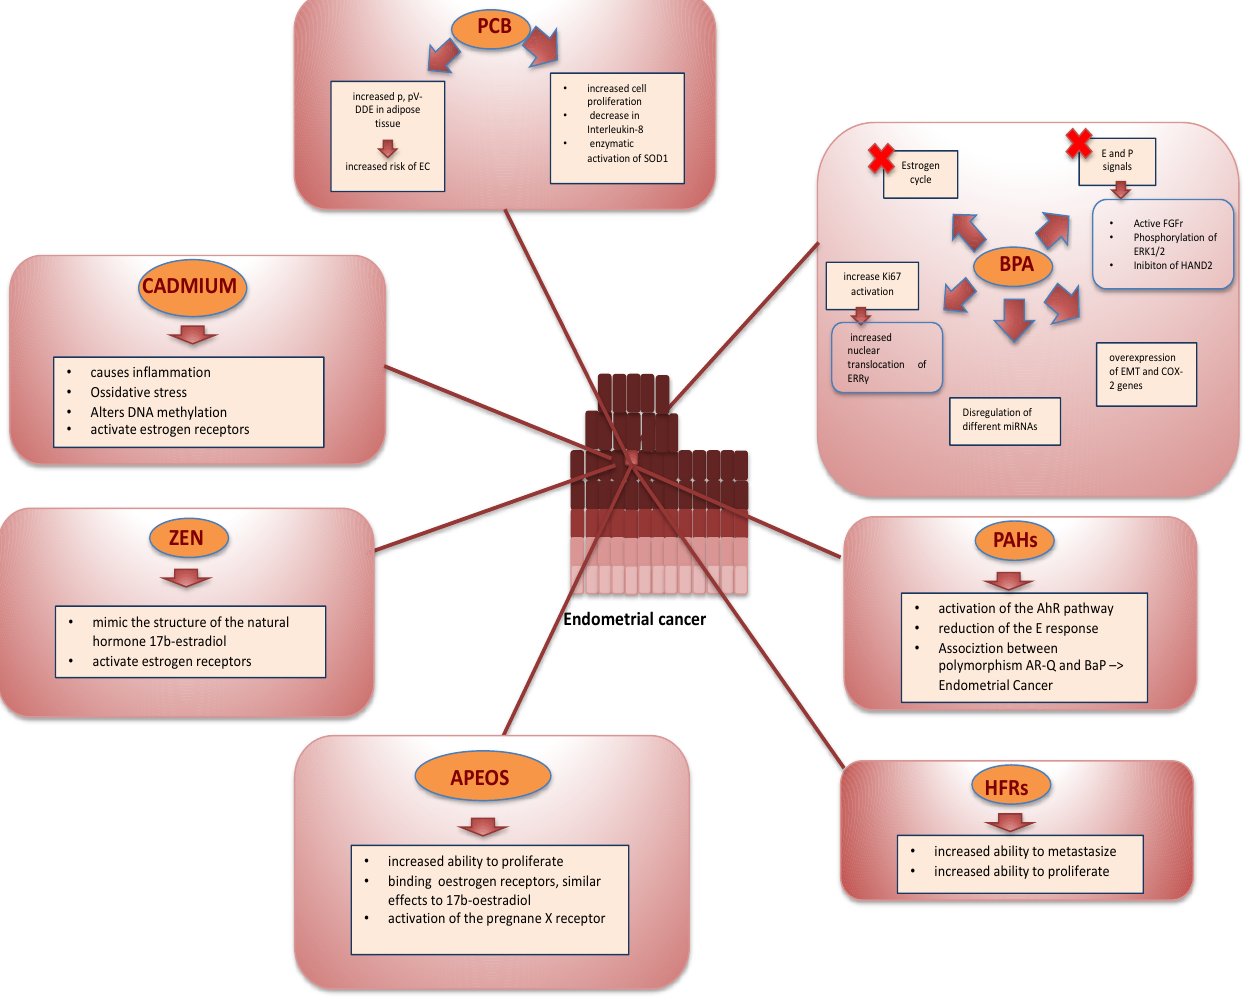
Figure 1. EDCs and EC. Bisphenol A:BPA; E: Estrogen; P:progesteron; fibroblast growth factor receptor: FGFr; Extracellular signal-regulated protein kinases 1 and 2: ERK1/2; Heart- and neural crest derivatives-expressed protein 2:HAND2; epithelial-mesenchymal transition: EMT; cyclooxygenase- 2:COX-2; MicroRNAs:miRNAs; increased nuclear translocation of estrogen-related receptor γ (ERRγ); Polycyclic aromatic hydrocarbons: PAHs; aryl hydrocarbon receptor:AhR; poly-glutamine poly- morphism: AR-Q; benzo(a)pyrene: BaP; Halogenated flame retardants:HFRs; Ethoxylated alkylene: APEOS; zearalenone:ZEN; Polychlorinated Biphenyls: PCB; p,p’-dichlorodiphenyldichloroethylene: p,p’V-DDE: superoxide dismutase 1:SOD1; red cross: